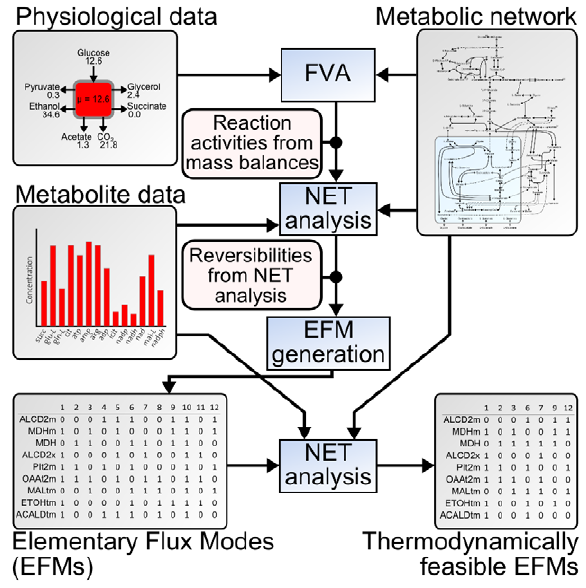
Figure 1. Overview of procedure to identify thermodynamical- ly feasible EFMs. We use a metabolic network model of S. cerevisiae together with physiological data (e.g., growth rate, glucose uptake, ethanol production) in flux variability analysis (FVA) to determine reaction reversibilities and reaction activities for the specific conditions. Subsequently, we apply NET analysis to determine additional reaction direction constraints based on the activities of reactions that are active for all flux distributions. With the resulting condition specific reaction directionalities, we calculate all the EFMs for the metabolic network. Finally, we use quantitative metabolite data to test the reaction activities of each EFM for thermodynamic feasibility.